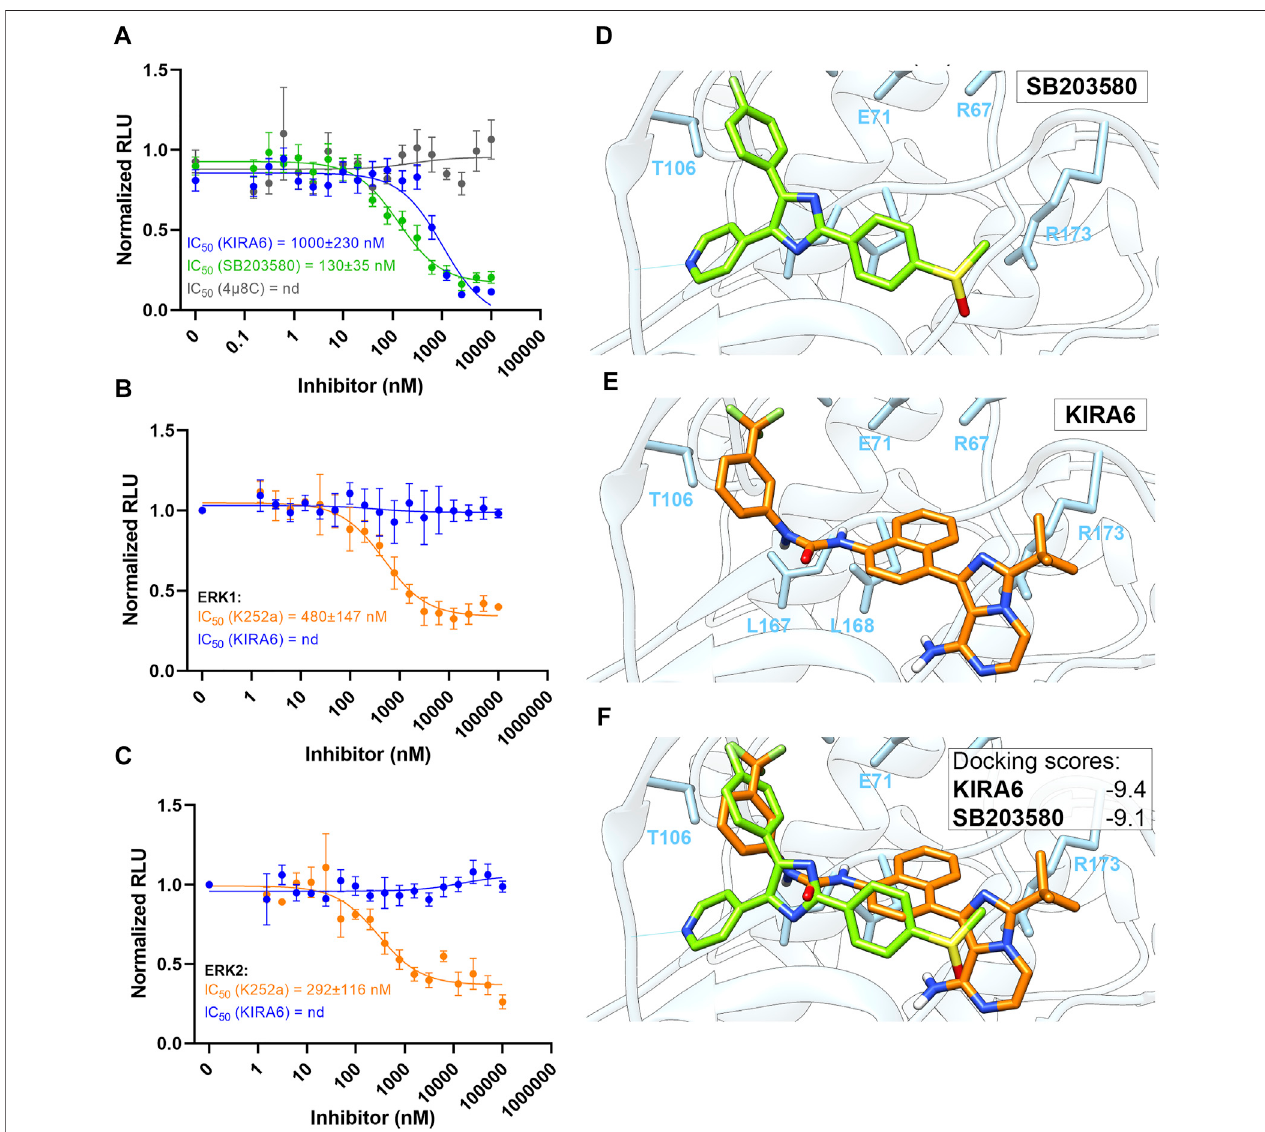
FIGURE 4 | Molecular docking of KIRA6 into the active site of p38. (A) Dose response curves of p38 kinase activity inhibition by KIRA6 (blue trace; n = 10), SB203580 (green trace; n = 4) and 4 µ8C (grey trace; n = 4). (B,C) Dose response curves of ERK1 (B) and ERK2 (C) kinase activity inhibition by KIRA6 (blue trace) and K252a (orange trace) ( n = 4). (D – F) Binding conformations of KIRA6 (orange) and SB203580 (green) in the active site of p38 and the respective docking scores.